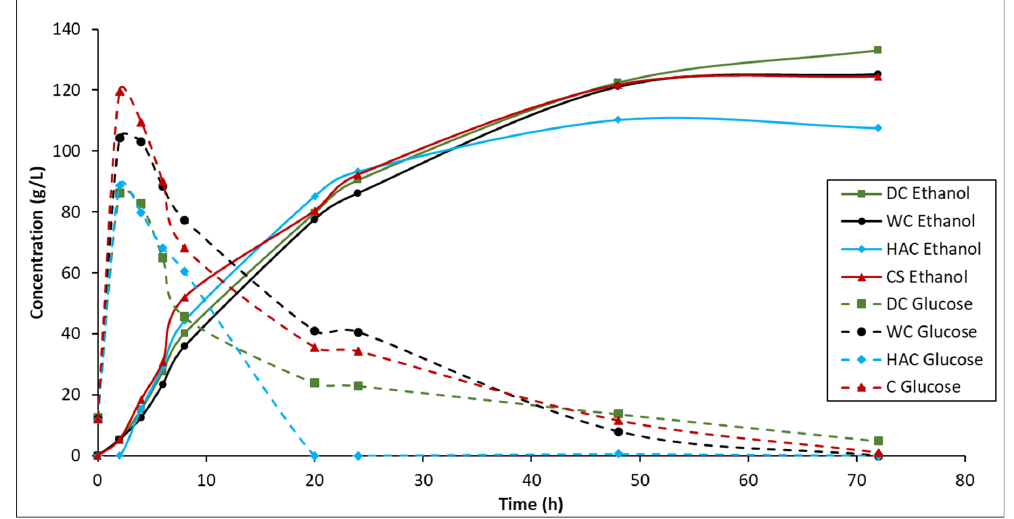
Figure 3. Comparison of ethanol and glucose profiles of dent corn (DC), waxy corn (WC), high amylose corn (HAC), and cassava starch (CS) during conventional fermentation (SSF at 30 °C for 72 h with glucoamylase and yeast).